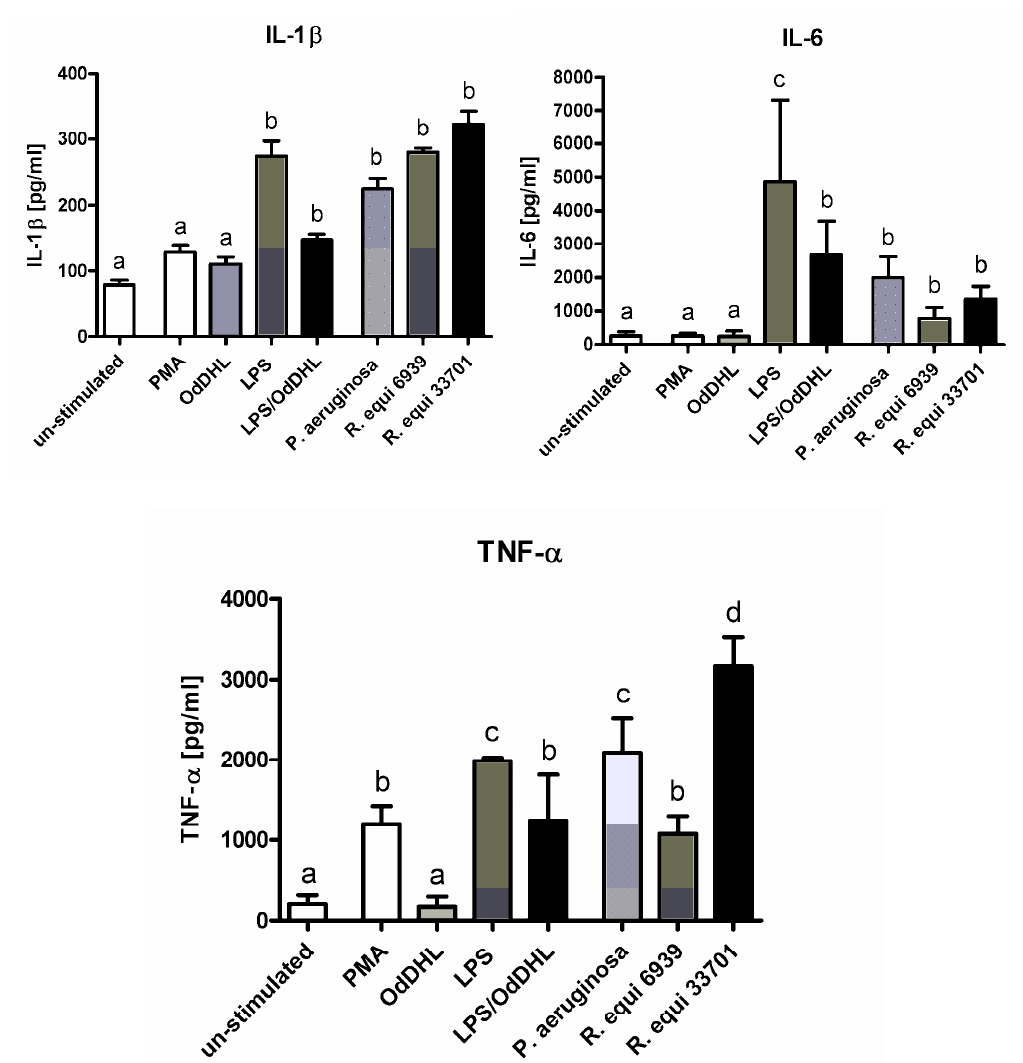
Figure 1. Concentration of IL-1 β , IL-6 and TNF- α in supernatants of RAW264.7 macrophages, cultured in basic medium after 24 h of stimulation with lipopolysaccharide (LPS), N -(3-oxododecanoyl)- L -homoserine lactone (OdDHL), LPS + OdDHL, phorbol-12-myristate-13-acetate (PMA), P. aeruginosa ATCC 10145, R. equi ATCC 6939 and R. equi ATCC 33701 respectively. Data are mean ± SD ( n = 6). Bars denoted by different letters are significantly